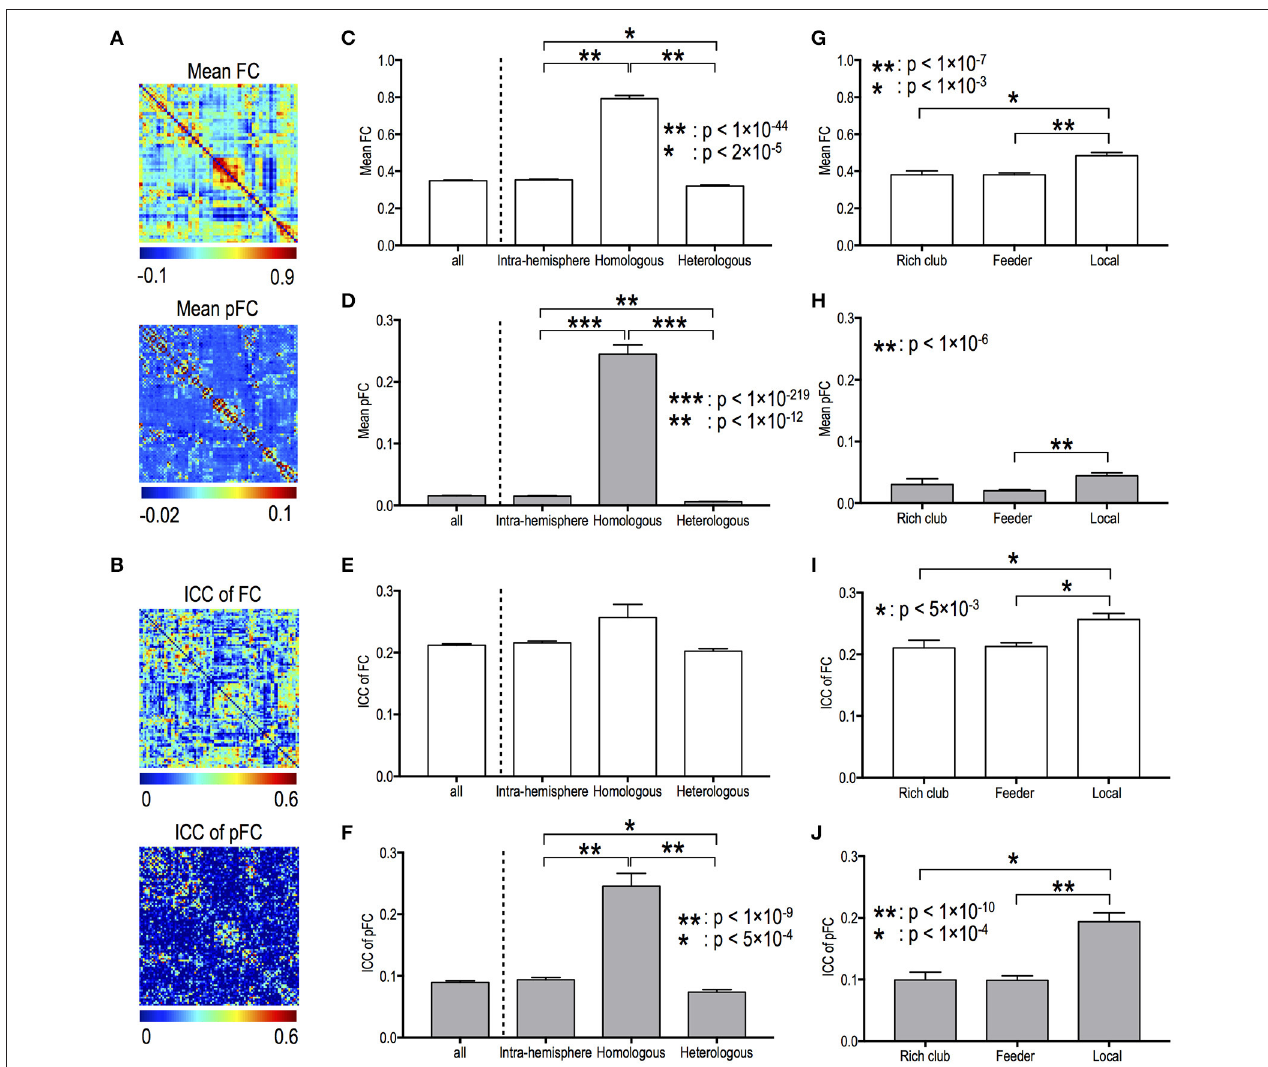
FIGURE 2 | Mean functional connectivity strength and its stability according to edge types. Spatial patterns of mean functional connectivity (A) and of functional connectivity stability (i.e., ICC) (B) . Mean and ICC of FC and pFC according to the inter- and intra-hemispheric edge types (C–F) and according to topological edge types in rich-club organization (G–J) . FC: Pearson correlation-based functional connectivity, pFC: partial correlation-based functional